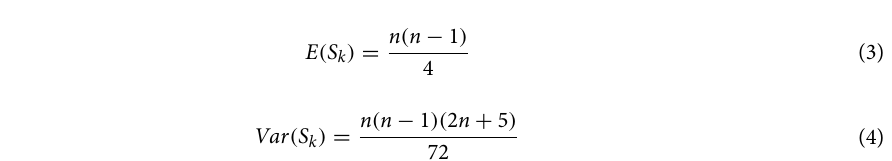
Figure 2. Case Analysis of mutation points in special years (West SOS, 2000) based on MKtest ( a 16 days; b